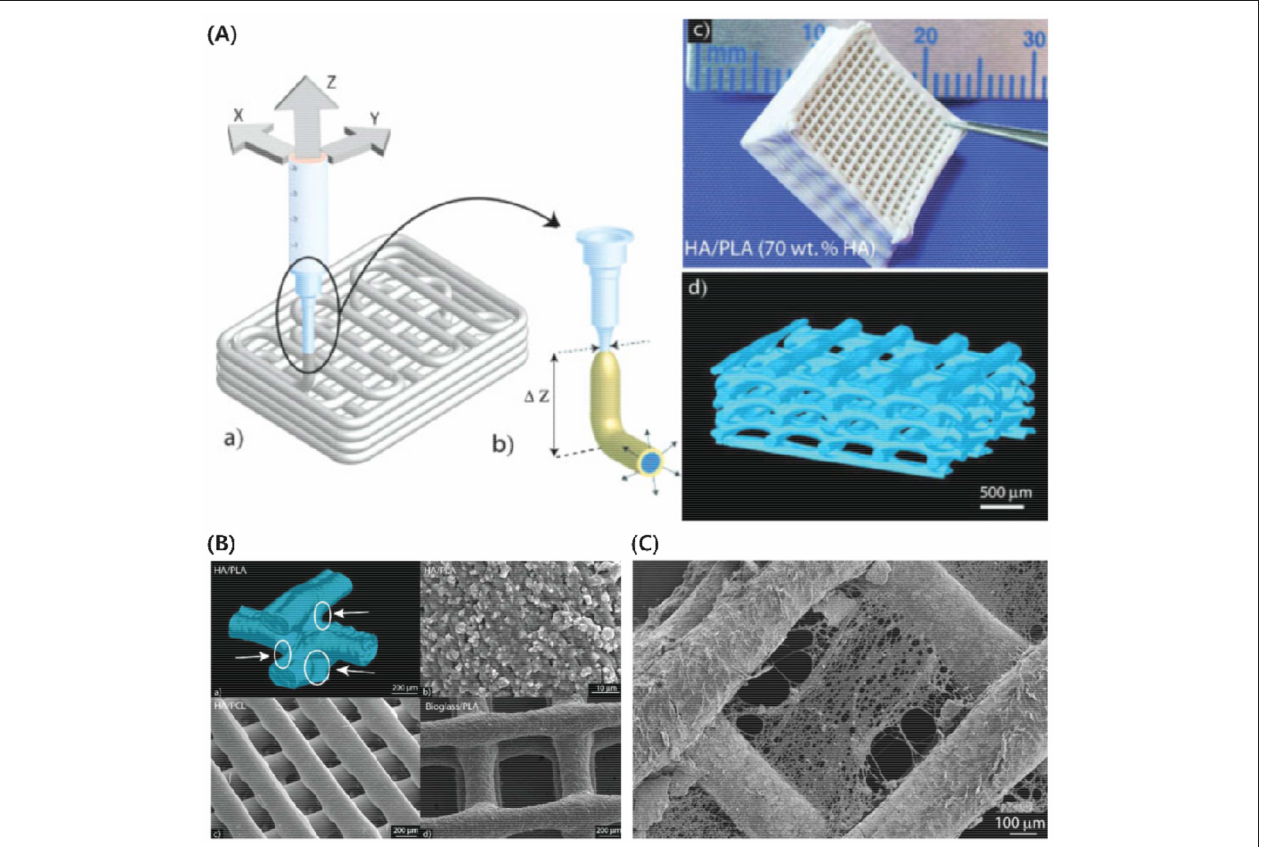
FIGURE 7 | (A) Schematic of the robocasting process showing liquid flow via the nozzle (a), inks tend to swell after leaving the nozzle during printing and form a solid skin printed lines after evaporation of solvent (b), digital image of PLA/HAp (70 wt-%) printed scaffold of 17 layers (c), and 3D reconstructed image of PLA/HAp (70 wt-%) grid obtained by synchrotron X-ray computed tomography (d). (B) 3D reconstructed image of the junction between PLA/HAp (70 wt-%) printed filaments obtained by synchrotron X-ray computed tomography (a), SEM image showing homogenous distribution of HAp particles in PLA/HAp (70 wt-%) printed filament at higher magnification (b), homogenous PCL/HAp (70 wt-%), and PLA/6P53B glass (70 wt-%) printed filaments (c). (C) SEM image of PCL/HAp (70 wt-%) printed scaffold after 20 days incubation in SBF, where degradation on the surface of printed scaffold can be seen clearly. A nozzle having an internal diameter of 410 µ m has been used for all printed scaffolds. Reproduced from Russias et al. (2007) with permission from Wiley Periodicals,